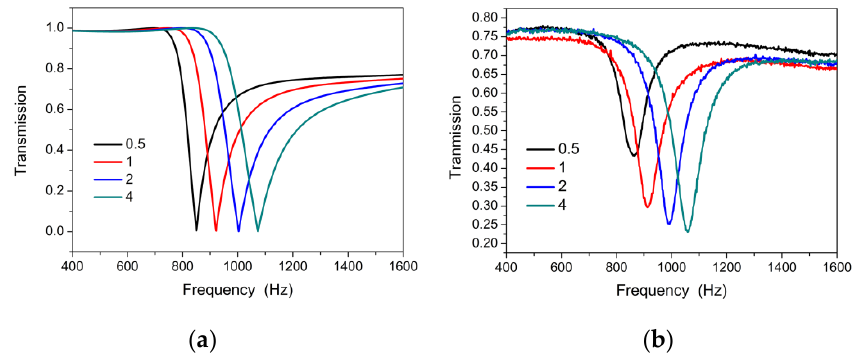
Figure 4. ( a ) The simulated and ( b ) experimental transmissions of the DSSHS AMMs with tuned distances, d 0 , from 0.5 to 4 mm.